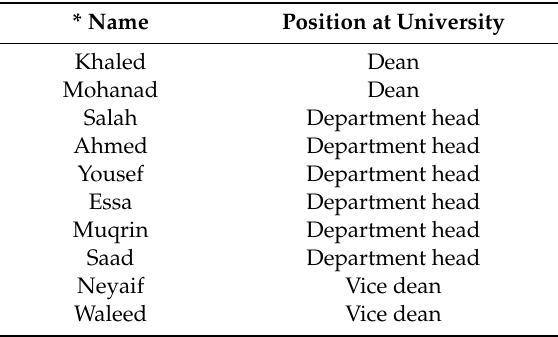
Table 2. Respondent profile (academic